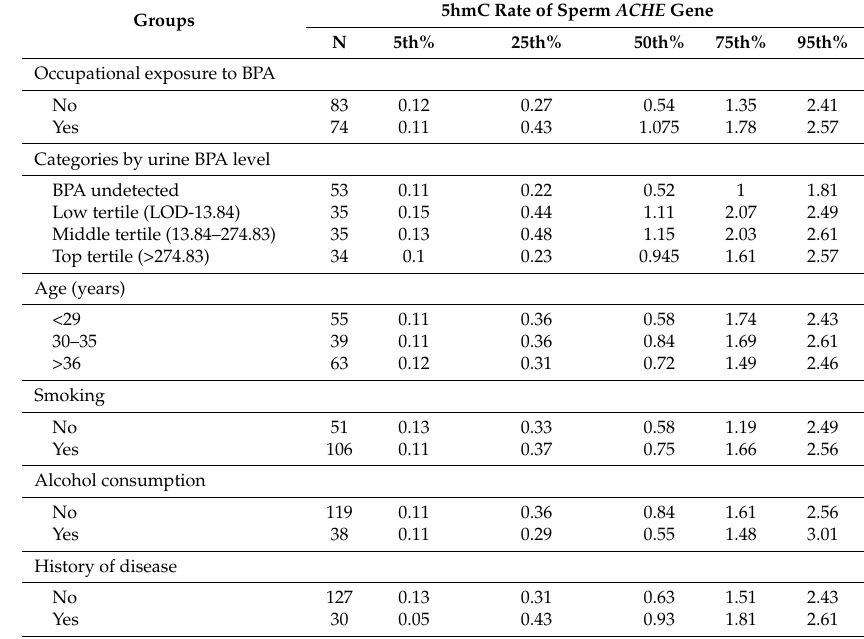
Table 2. Distribution of the 5-hydroxymethylcytosine (5hmC) rate of the sperm acetylcholinesterase ( ACHE ) gene by characteristics of the study population and BPA exposure.